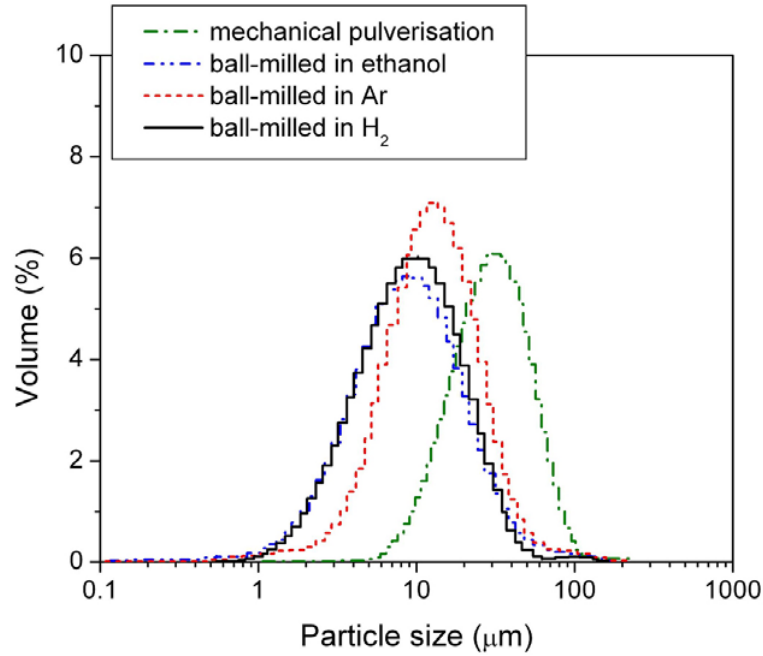
Figure 2. Particle size distribution of the mechanically pulverized HSA and of the HSAs ball-milled in different